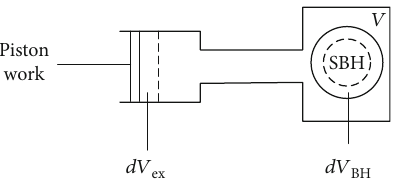
Figure 1: The illustration of a model for back reaction with a Schwarzschild black hole in a bulk volume surrounded by the radiation fi eld connected to a piston to the outside on the